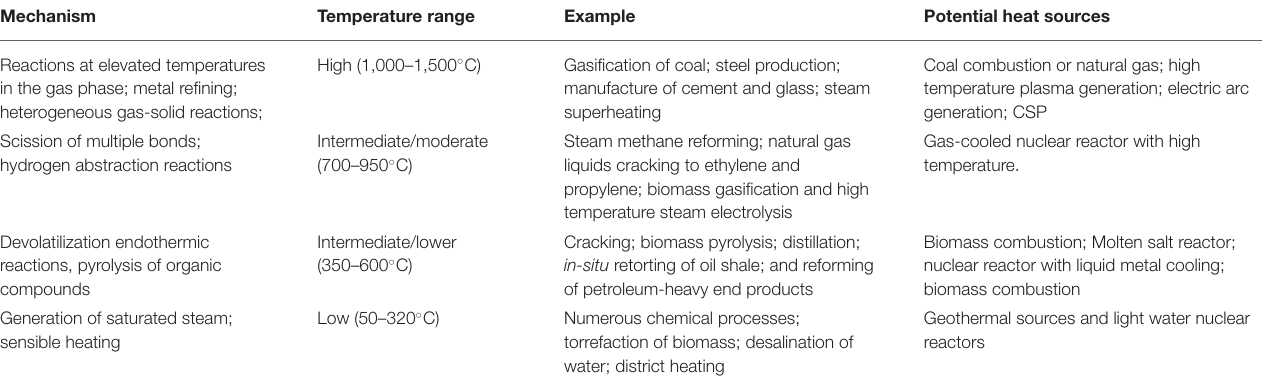
TABLE 4 | Temperature ranges corresponding to industrial process reactions mechanism with potential heat sources (Ruth et al., 2014). Mechanism Temperature range